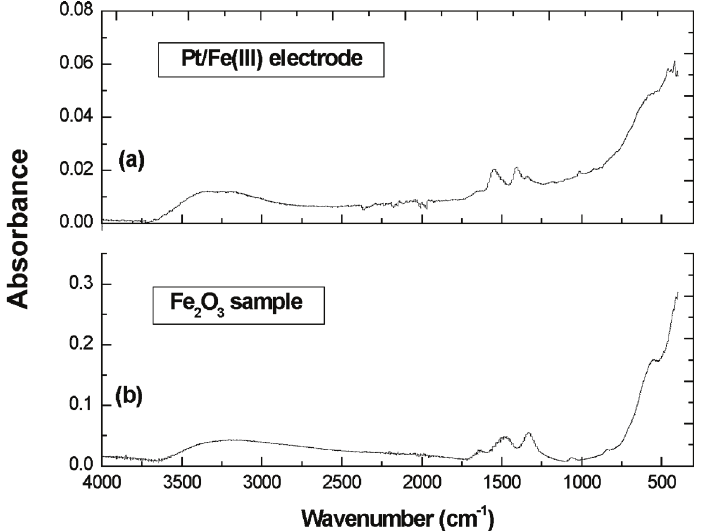
Figure 3. FTIR diffuse reflectance spectrum (in absorbance mode) of (a) a Pt/Fe(III) electrode and (b) a Fe O sample. The electrodeposition conditions of Pt/Fe(III) are 2 3